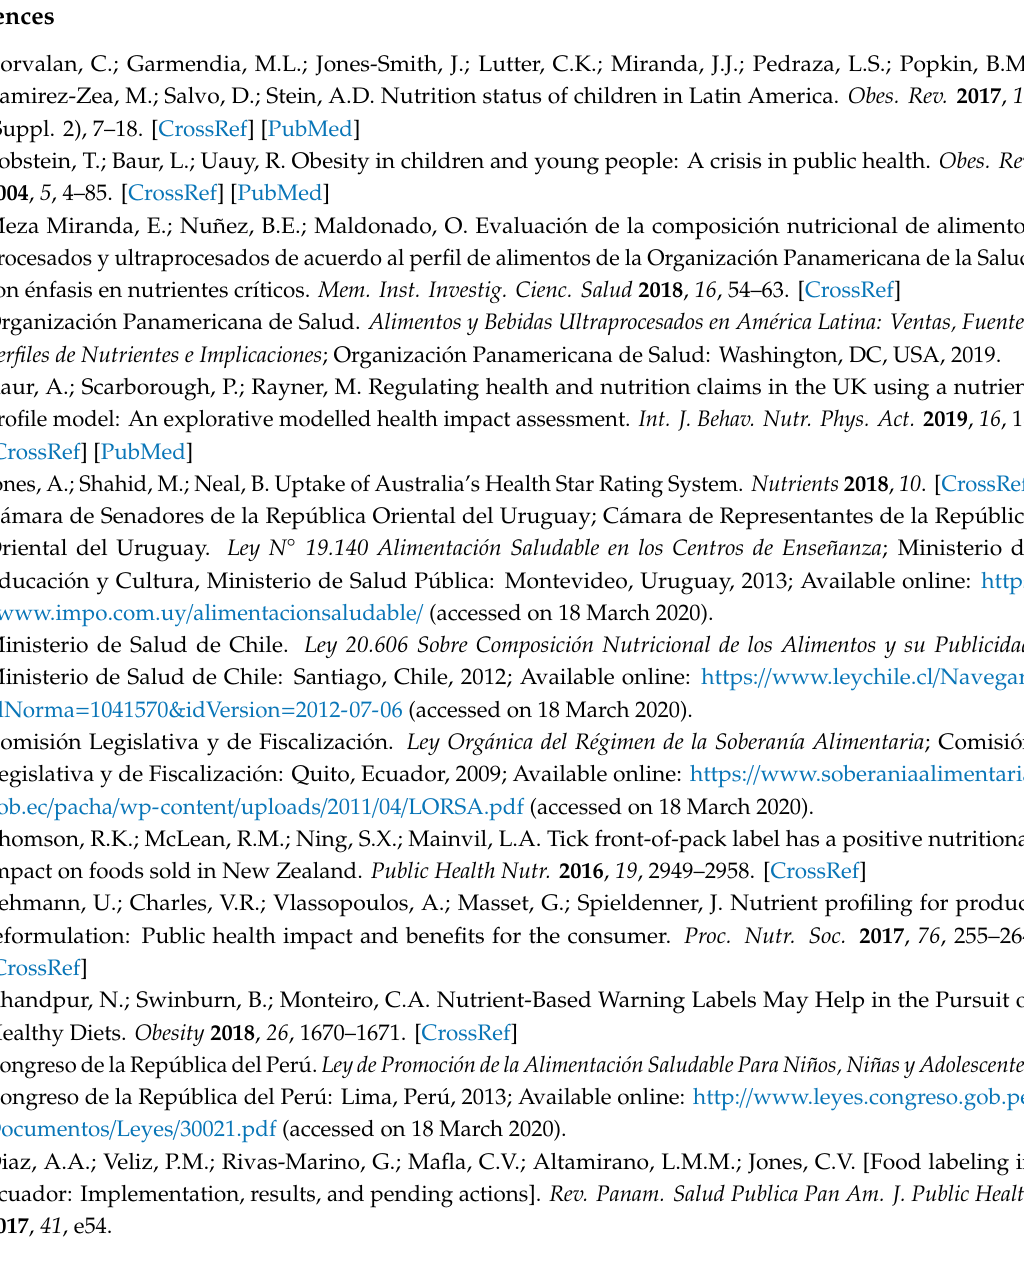
Supplementary Material 1: Example of a photograph group, Supplementary Material 2: Categories of food and beverages adapted from Chilean studies adapted to the Peruvian